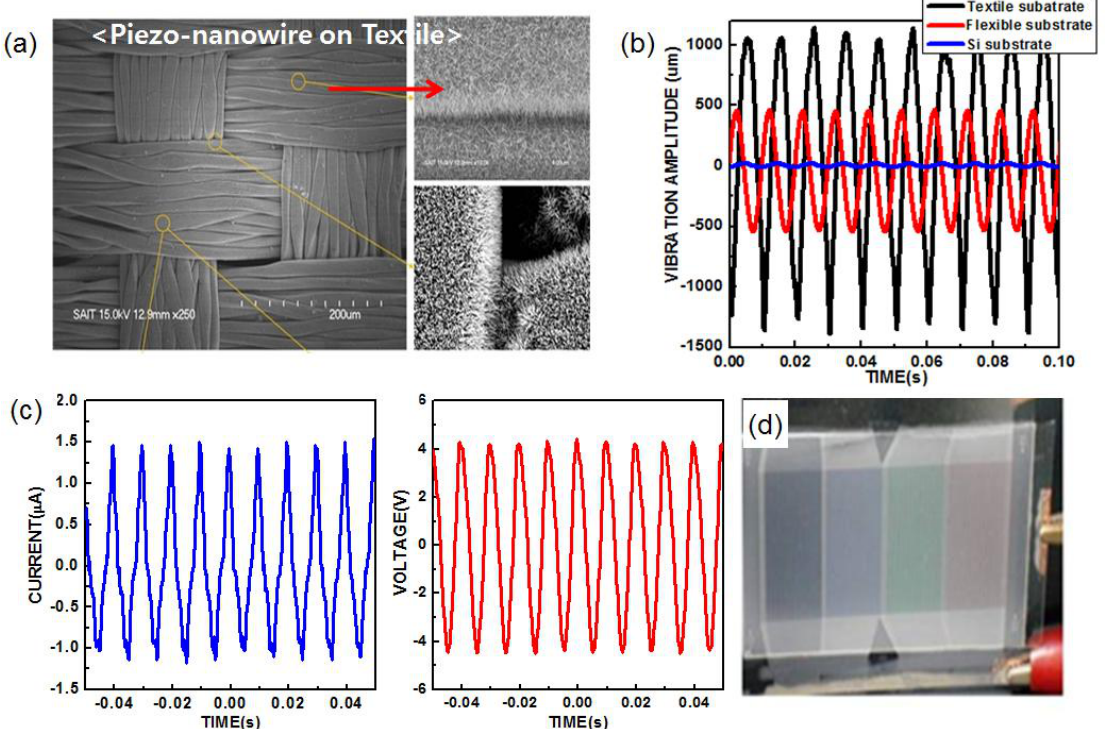
Figure 10. ( a ) Large-area SEM images of ZnO nanowires grown on a textile substrate; ( b ) comparison of the vibration amplitude of the Si, flexible PES and textile substrates that were vibrated by a sonic wave; ( c ) output voltage and current from the large-area textile harvester (10 cm 2 ) at 100 dB and 100 Hz; ( d ) a PDLC display panel operated by the sound-driven textile harvester. Reprinted with permission from [46]. Copyright 2012, Royal Society of